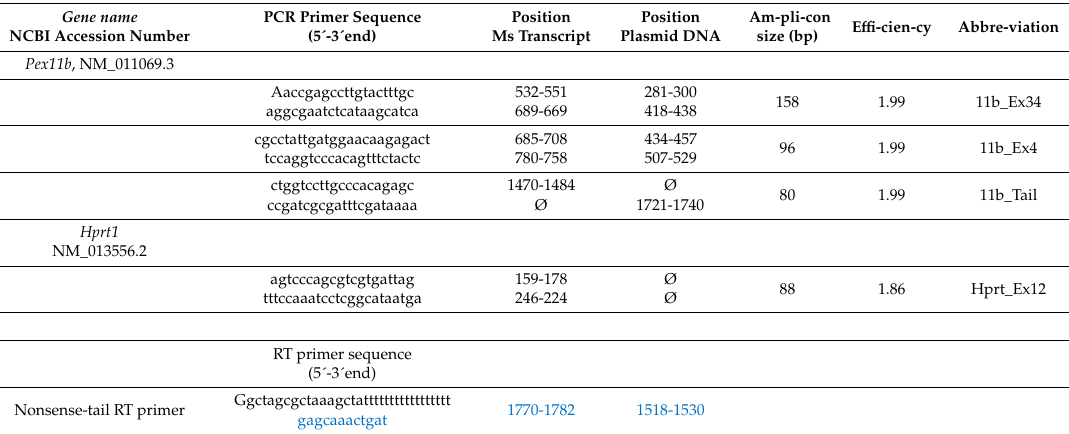
Table 1. RT and PCR primer sequences. List of primers used for the RT and qPCR reactions, including their gene names, gene bank accession (NCBI) numbers, sequences, binding positions, amplicon lengths, e ffi ciency coe ffi cients and their abbreviations used throughout this manuscript. The nonsense-tail sequence with no similarity to the mouse genome is highlighted in